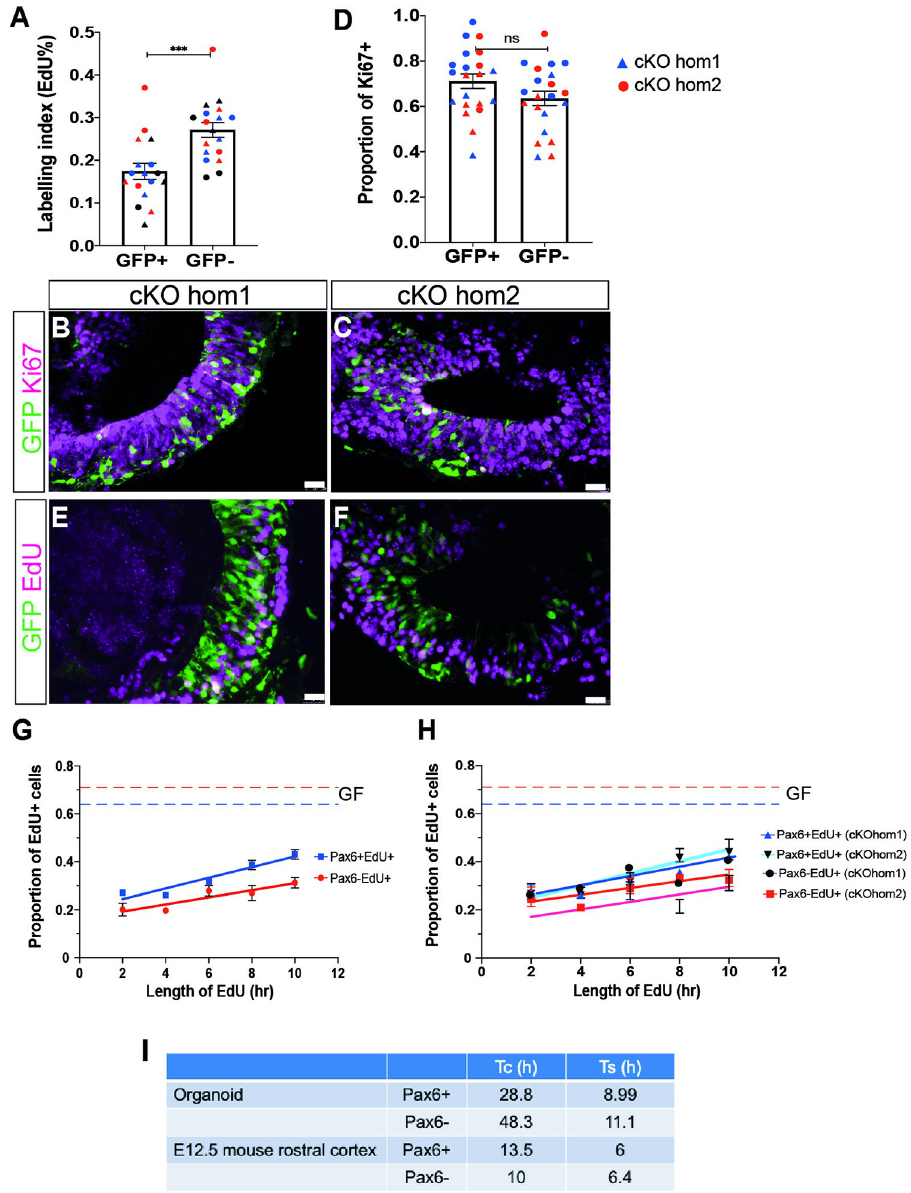
Fig 4. Analysis of cell cycle parameters in Pax6 cKO cerebral organoids. (A) Labelling index in GFP+ (Pax6-) and GFP- (Pax6+) cells in 4OHT treated cKO organoid neuroepithelium following a two hour pulse of EdU label. Each data point represents 1 organoid. Both cKO lines combined, n = 9 organoids for each line, consisting of 3 organoids from each of 3 independent batches (colour coded red, blue & black). (B,C) Ki67 staining of 4OHT treated cKOhom1 and cKOhom2 organoids to identify actively proliferating cells. (D) Graph showing proportions of Ki67 positive GFP + and GFP- cells in 4OHT-treated Pax6cKO organoids on day 8. n = 21 organoids in total, 4–6 organoids from each of two batches of organoids grown from each line (batches colour coded red and blue, triangles indicate cKOhom1 and circles cKOhom2). (E,F) Representative images of 4OHT-treated cKO organoids labelled with a 2 hour pulse of EdU. (G,H) EdU cumulative labelling show an increase in the proportions of EdU+ cells in both GFP+ and GFP- cells. Data presented as means ± SEM (n = 6 batches, 3 batches per line). In (G), cKOhom1 and cKOhom2 data are combined, these are shown separately in (H). (I) Table summarising Tc and Ts values in Pax6+ and Pax6- cells in organoids and E12.5 mouse